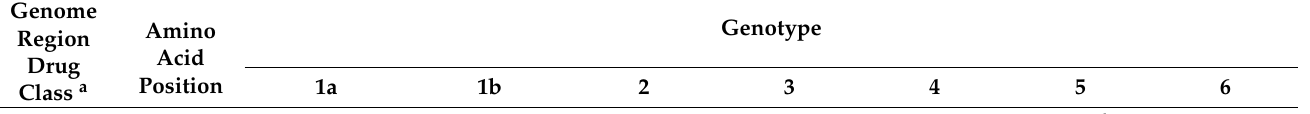
Table 2. Substitutions associated with resistance to HCV direct acting antivirals